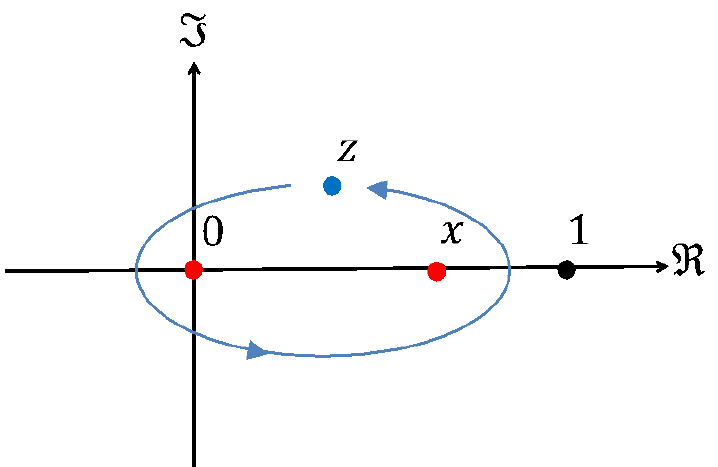
Figure 1 . Since the operator O p arises from the OPE between O 1 and O 2 , the monodromy of (cid:9) p around O p is given by encircling both points z = f 0 ; x g along a blue